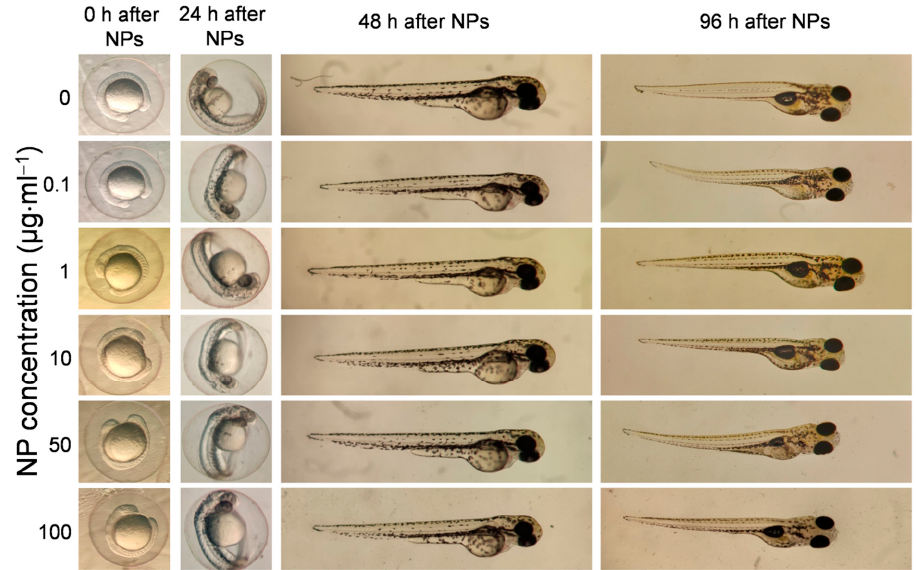
Figure 5. Morphological analysis of zebrafish embryos exposed to different concentrations of Fe@Au NPs at different times (0, 24, 48, and 96 h).